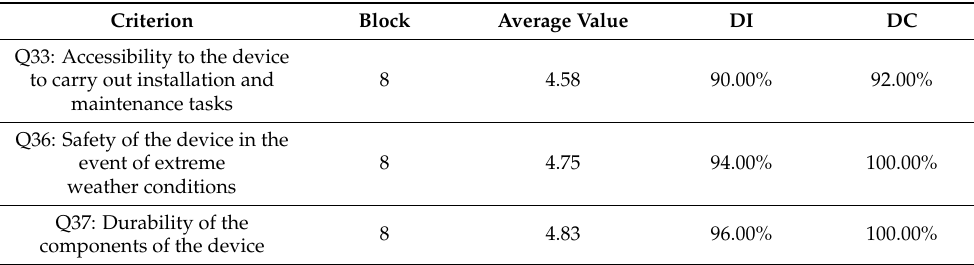
Table 10. Criteria meeting DI ≥ 90% and DC ≥ 90% values.